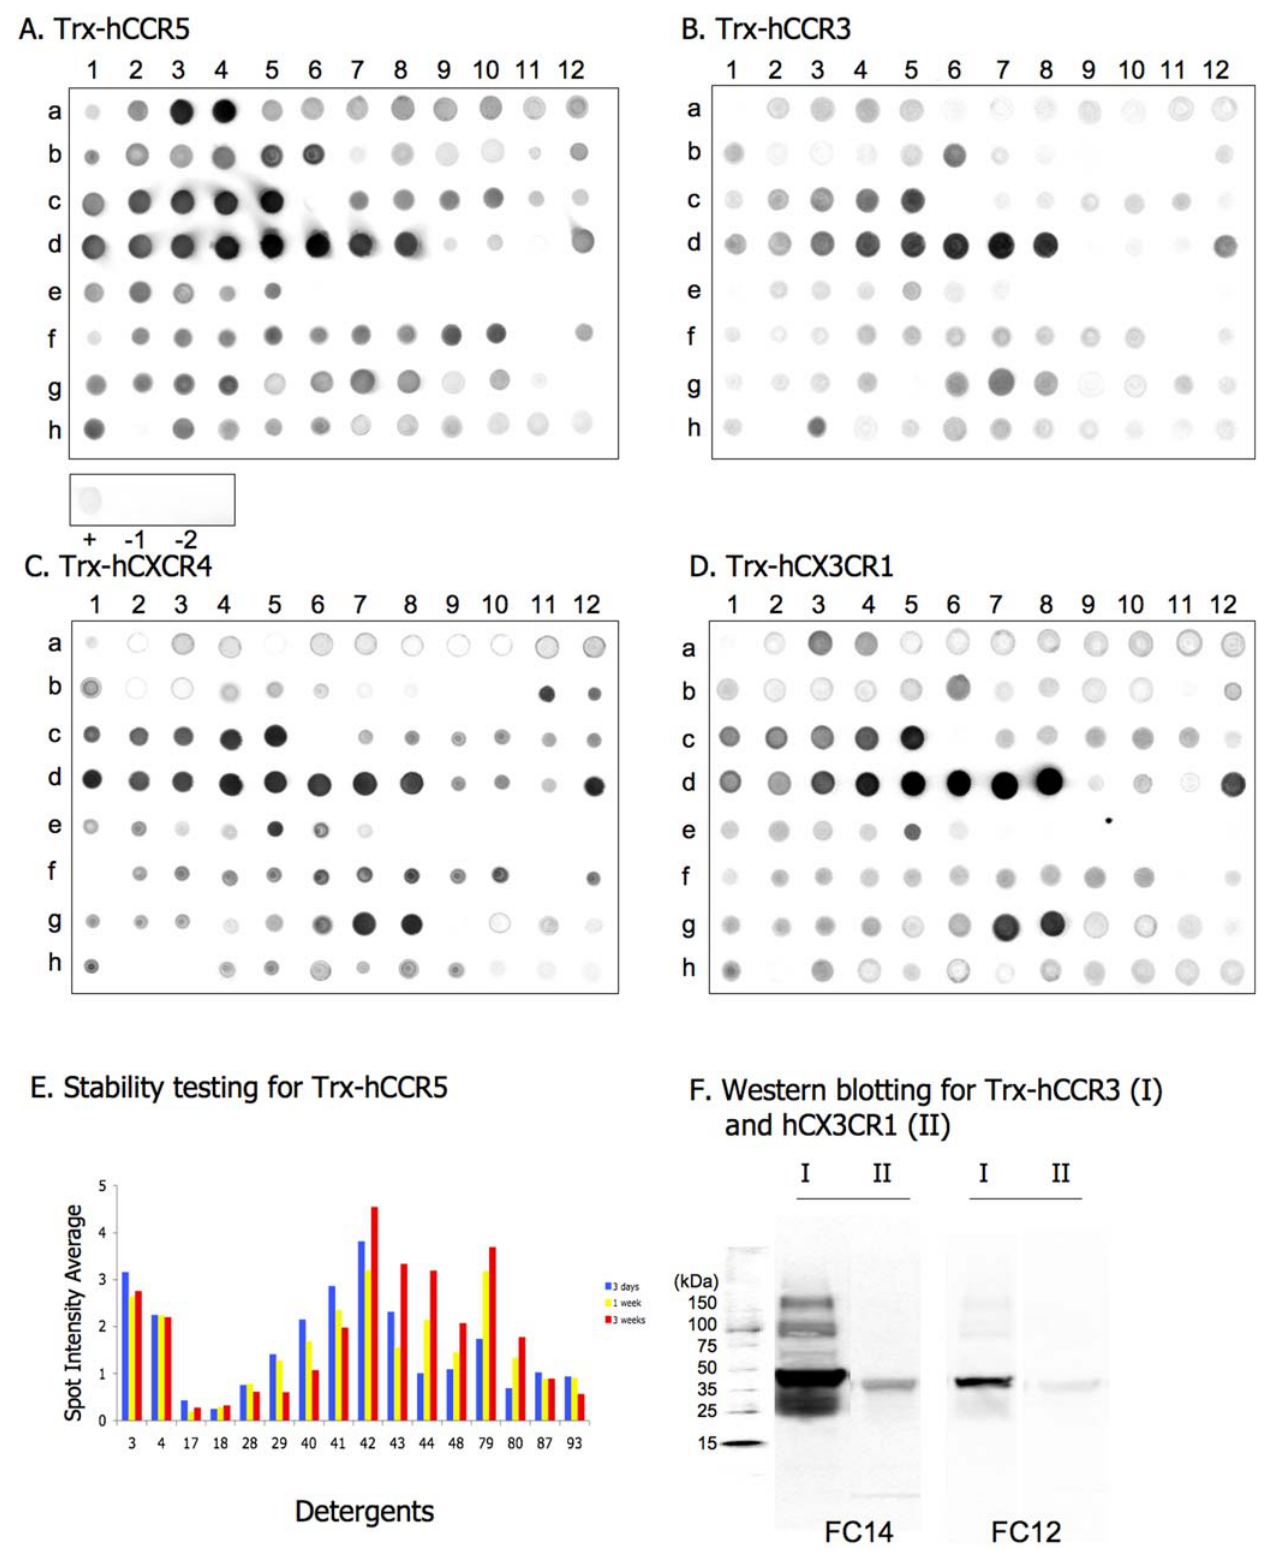
Figure 6. Detergent screening for solubilization of Trx-hCRs expressed by pBAD-hCRs in Top10. A)–D) Effectiveness of the 96 detergents on solubilizing Trx-hCRs from cell lysates, as detected by Dot blot. Immunoblotting analysis was performed using mouse anti-His 6 -tag monoclonal antibody. Each filter has 96 spots (a1 to h12), corresponding to the 96 detergents listed in Figure 5. Controls shown in (A) are positive control ( + ) using 1:100 dilution of BenchMark His-tagged protein standard; negative control ( 2 1) was pBAD-hCCR5 in Top10 cultured in the absence of inducer; negative control ( 2 2) was L-arabinose induced sample solubilized without the addition of detergent. The negative controls were processed in